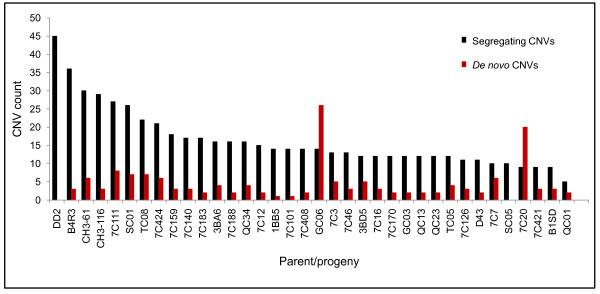
Total CNVs detected per individual parasite clone. The number of CNVs per progeny ranged from 8 in QC01 to 45 in B4R3 with a median of 36 CNVs per individual genome. In comparison, the parental genomes contain 45 CNVs. With respect to the CNVs in each individual progeny, segregating CNVs generally constitute the majority, except in GC06 and 7C20 where the majority of the CNVs are de novo.